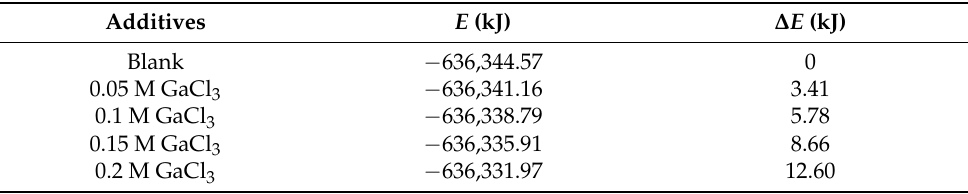
Table 5. Energy and energy changes of 1 mol Al in 2 M NaCl solution without and with different